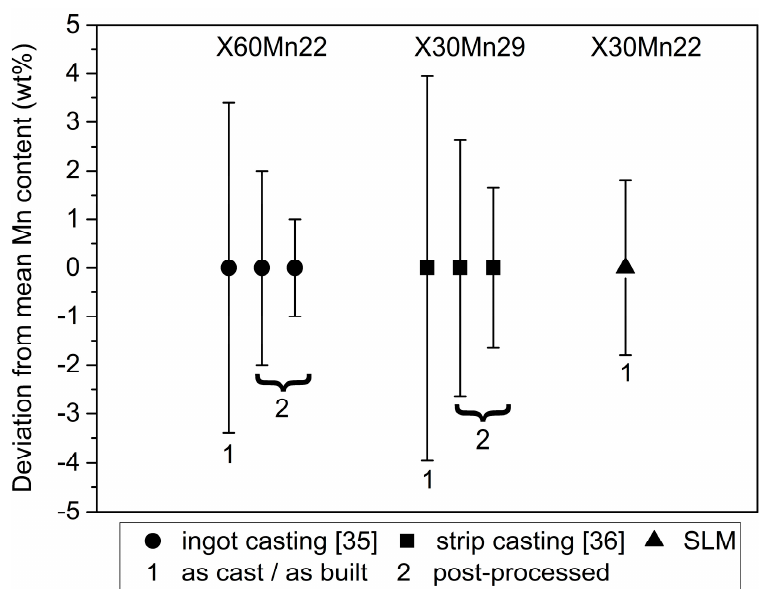
Figure 7. Comparison of the deviation of the Mn content from the mean Mn value depending on the processing route. An X60Mn22 (ingot casting) [35] and an X30Mn29 (strip casting) [36] steel were used for comparison. The Mn deviation after both ingot and strip casting is much higher compared to the as-built SLM material. The ingot-cast steel was post-processed by forging and annealing (middle circle) as well as additional hot rolling (right circle). The strip-cast steel was post processed by cold rolling and annealing at 900 °C for 30 min (middle square) and at 1150 °C for 30 min (right square).